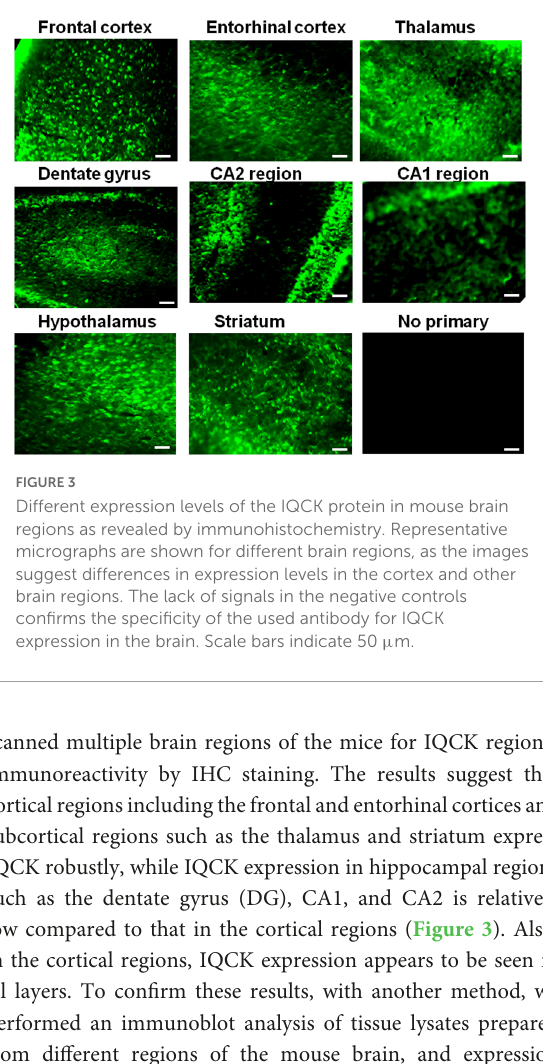
FIGURE2 Immunohistochemical evidence for IQCK protein expression in both human and mouse brains. (A) Shows similar anti-IQCK antibody immunoreactive (green) cytoplasm and nuclei in human and mouse brain cells, while negative controls without the primary antibody lack signals. (B) Shows neuronal processes also expressing the IQCK protein. Scale bars indicate 20 µ m in (A) and 50 µ m in (B) .